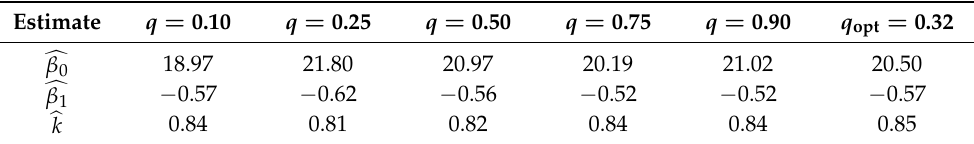
Table 13. Estimates of the parameters of the Weibull quantile regression model considering different quantiles, with insulating fluid data. Estimate q =